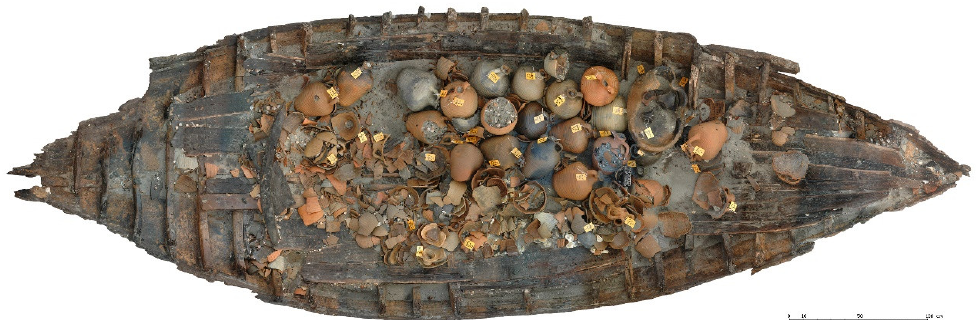
Figure 1. Photo of the Yenikapı 12 shipwreck ( © IU Yenikapı Shipwrecks Project Archive).